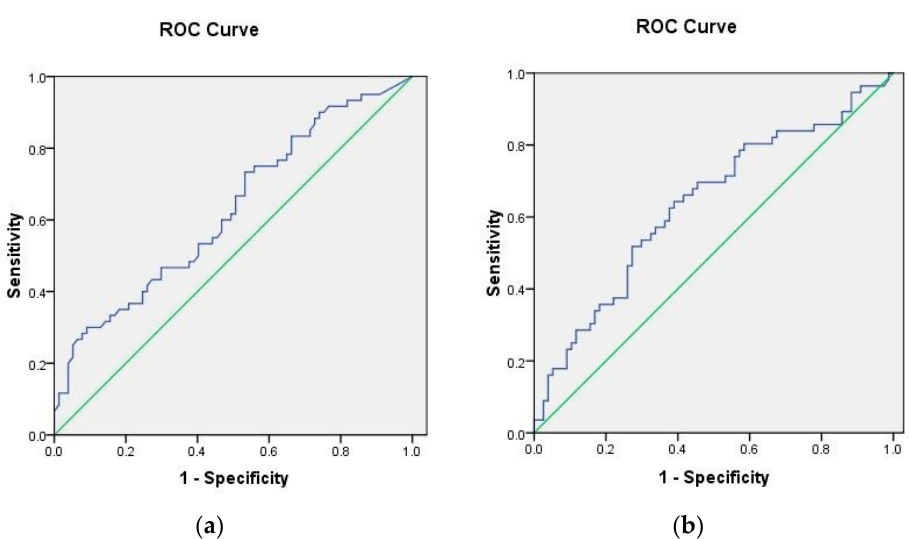
Figure 2. Receiver operating characteristic (ROC) curves for ( a ) TNF- α and for ( b ) HOMA C-peptide.